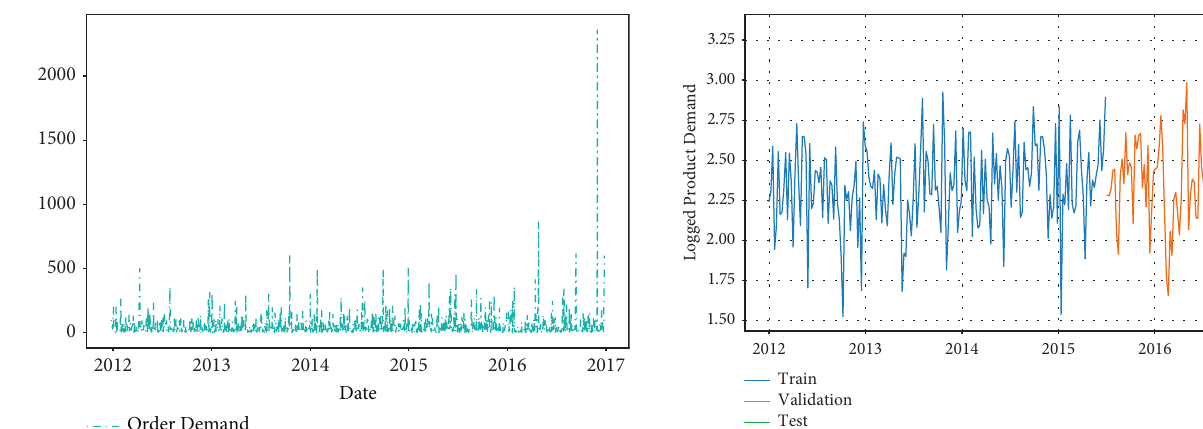
Figure 5: Distribution of demand data for original goods.